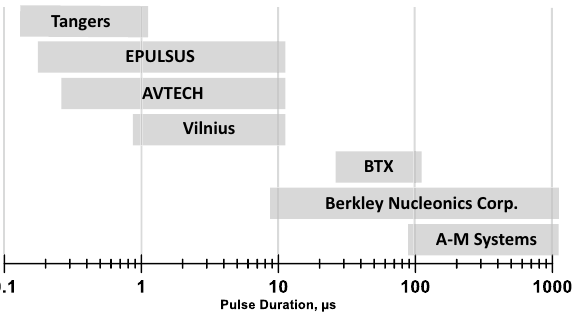
Figure 1. The range of pulse durations covered by different generators employed in this study. See text for more trains of 10, 100, or 300 pulses at 10 Hz. Pulse shape and amplitude were continuously monitored with a TDS 3052 oscilloscope (Tektronix, Beaverton, OR, USA). The EPULSUS generator was employed to produce a bipolar electric field, by alternating the energized elec- trode (anode) with the ground electrode 43 . Studies with bipolar PEF were limited to short pulses (≤ 10 µs) which are expected to evoke the bipolar cancellation effect 25,32,43 . The duration and amplitude of the second phase were always set equal to the first phase. The amplitude and duration of bipolar pulses reported in this paper are those of the first phase (the peak-to-peak amplitude and the total pulse duration are twofold larger). “long” pulses (≥ 100 µs) at lethal intensities caused intense bubble formation at the cathode. The bubbles cover- ing the electrode surface could unpredictably change the electric field distribution during a pulse train. Increas- ing the cathode diameter reduced the electric field strength at its surface and eliminated bubble formation. In sets of experiments which included the “long” pulses, we used an asymmetrical electrode assembly (Fig. 2A) for all pulse durations. The electrodes were made of stainless steel hollow rods, 1.2 mm outer diameter for cathode and 0.5 mm for anode. They were placed 2.2 mm apart (center-to-center), parallel to each other and orthogonal